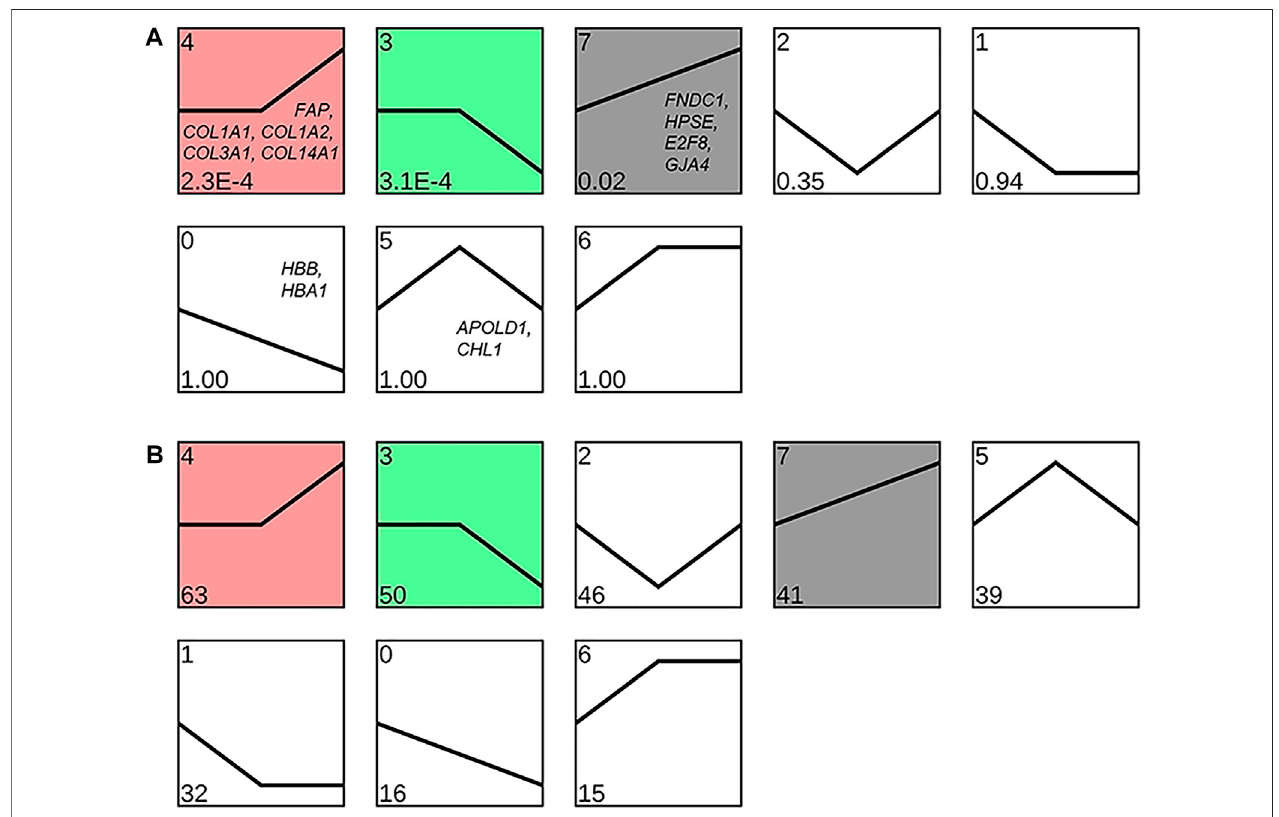
FIGURE 8 | Clustering analysis of the expression pattern of differentially expressed genes (DEGs) in Tibetan sheep lungs with increasing altitude. Expression patterns are shown based on the p -value (A) and number of DEPs (B) in the lower left corner; the genes in the patterns are the key DEGs enriched in the corresponding